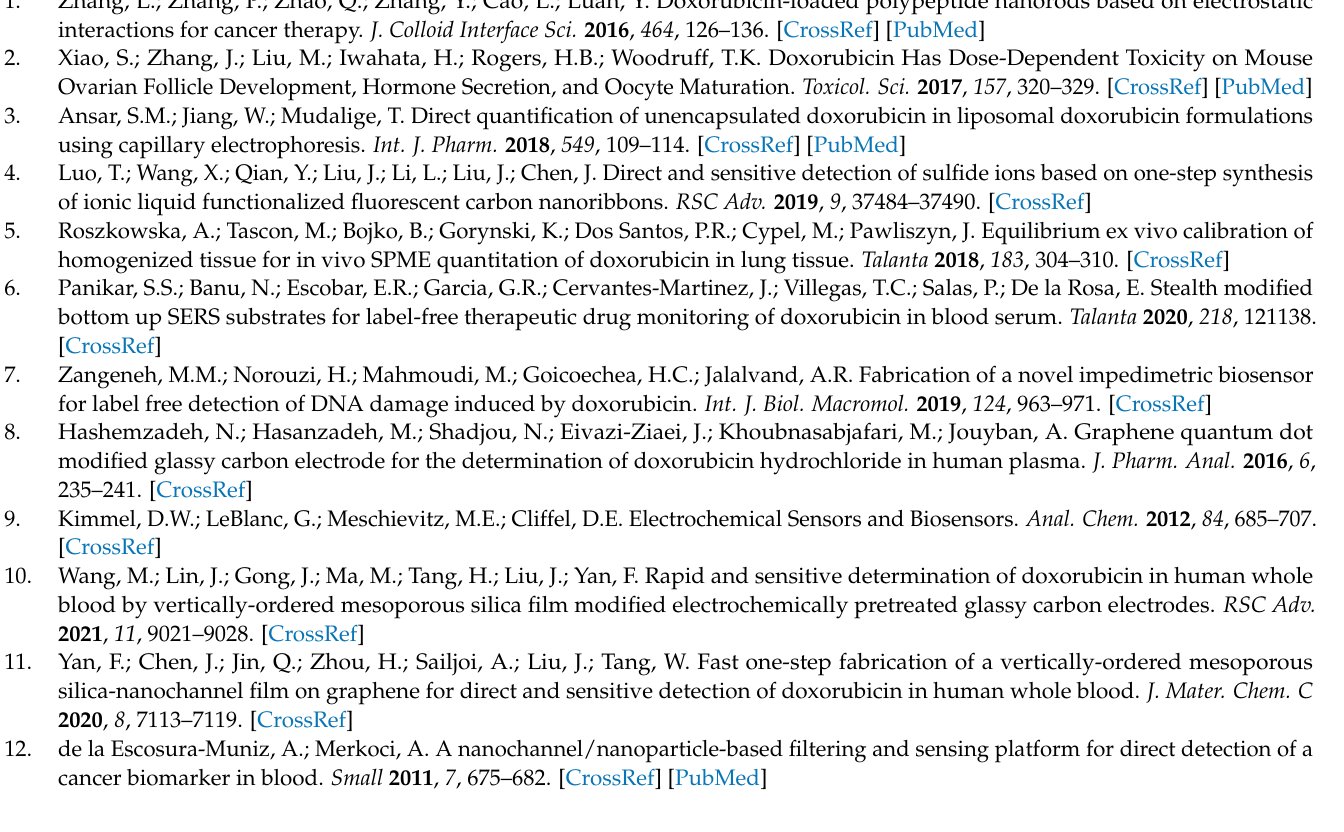
responses; Figure S2: Effect of growth time of VMSF on the detection performance; Figure S3: Optimization of preconcentration time and pH value of supporting